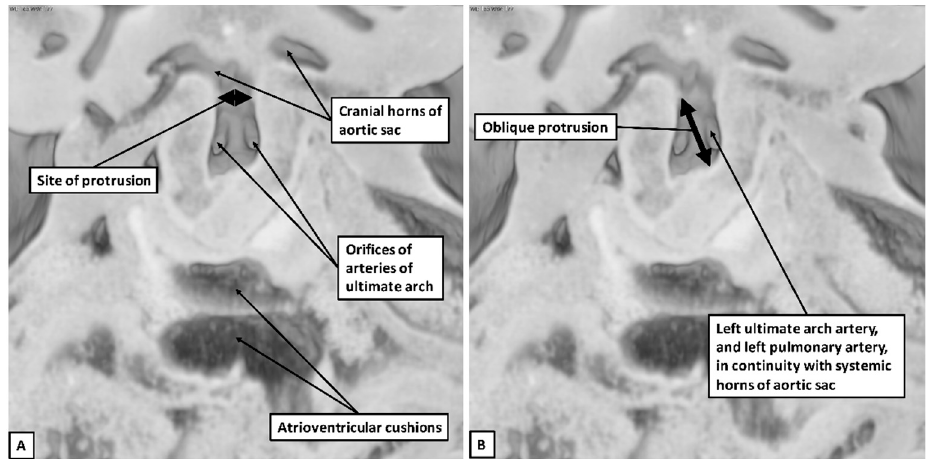
Figure 11. The panels show a possible explanation for anomalous intrapericardial aortic origin of the left pulmonary artery in the setting of a right aortic arch. Panel ( A ) shows the view of the aortic sac in a human embryo at Carnegie stage 13. At this stage, the cranial part of the aortic sac gives rise on each side to the arteries of the third and fourth pharyngeal arches, which will become the systemic arteries. The caudal part of the sac gives rise, again bilaterally, to the arteries of the ultimate pharyngeal arches, incorrectly described as the sixth arches since, as can be seen, there is no evidence of any fifth arch arteries. Normally the right-sided components of both the dorsal aorta and the ultimate arch artery regress, leaving a left-sided aortic arch and left-sided arterial duct. This requires formation of the aortopulmonary septum by growth of the dorsal wall between the cranial and caudal parts of the sac. The right hand panel ( B ) shows the consequence of growth of the dorsal wall, such that the origin of the left ultimate arch artery is incorporated into the systemic part of the sac, presuming that it is the left dorsal aorta and the left ultimate arch artery distal to the origin of the left pulmonary artery regress, leaving a right aortic arch and right-sided arterial duct.